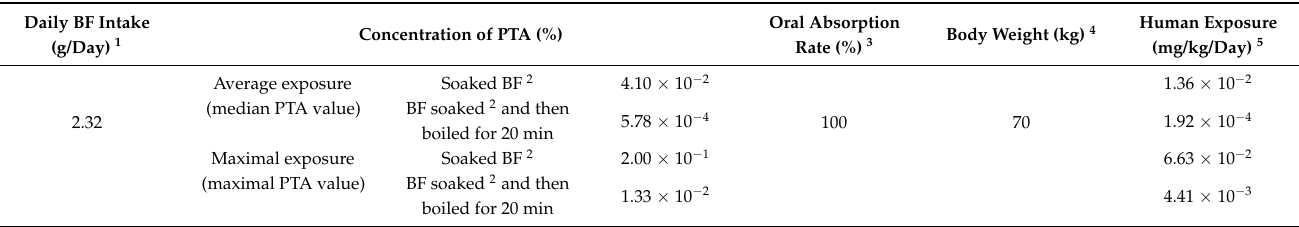
Table 3. Human exposure to PTA.